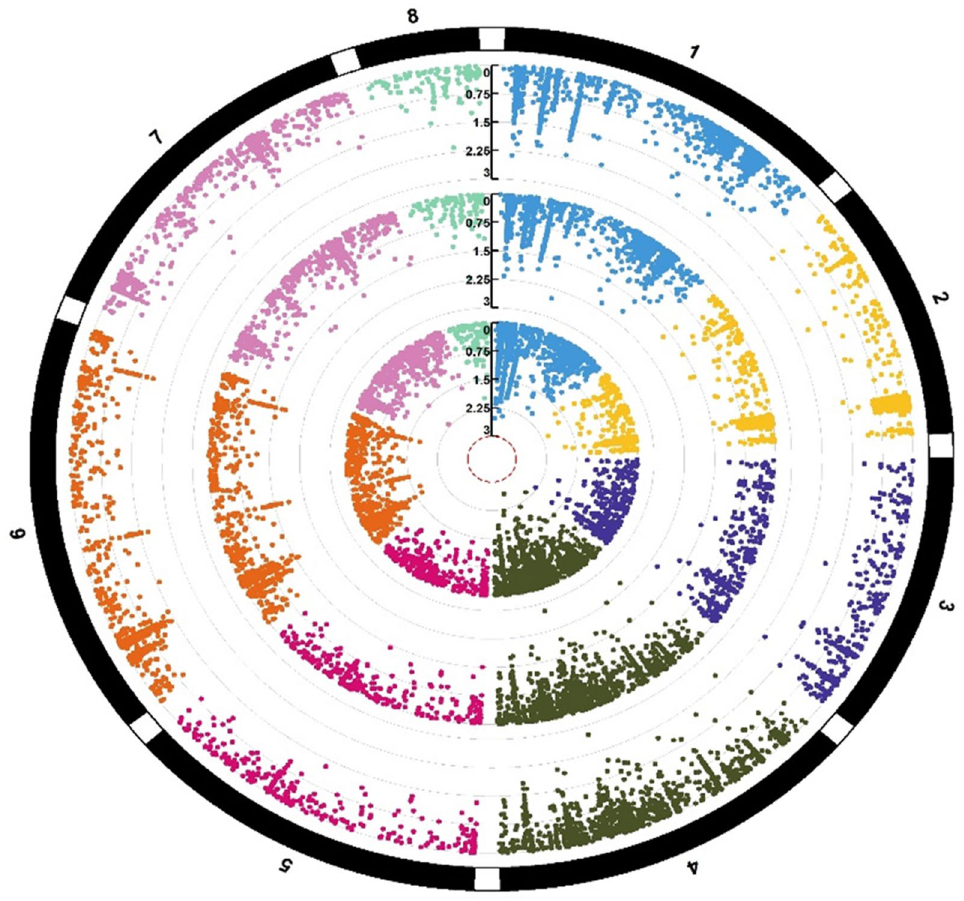
Figure 7. Circular Manhattan plots of showing marker-trait associations (MTAs) for seed Zn concentrations. The eight different colors represent 8 different chickpea chromosomes. The three concentric circles (each having 8 colors) shows MTAs identified for seed Zn concentrations in two environments and data pooled over